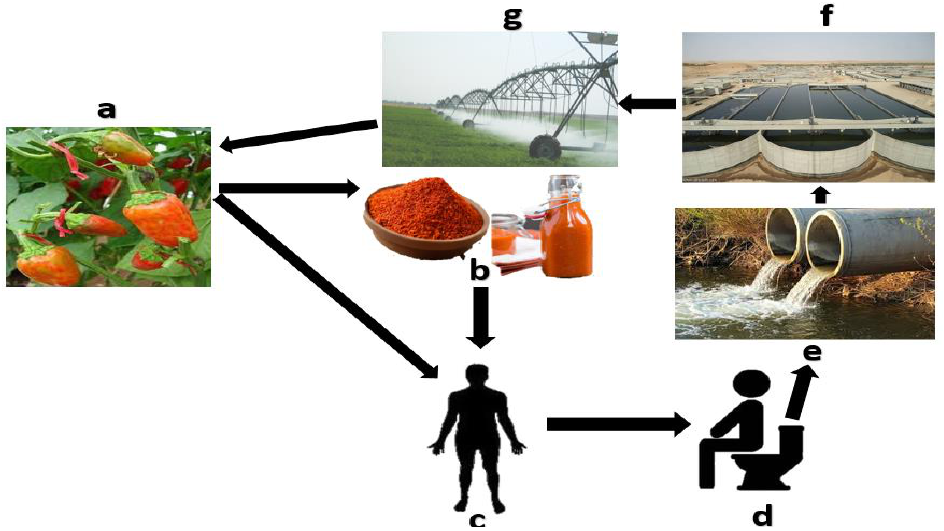
Figure 2. Transmission routes of PMMoV. PMMoV-infected pepper ( a ) is either used for preparation of powdered pepper products, in chili sauces ( b ) or directly consumed as a fresh product by humans ( c ). The human excreta ( d ) containing PMMoV are discharged into sewage water ( e ) that is prone to treatment approaches ( f ) for reuse in irrigation ( g ).